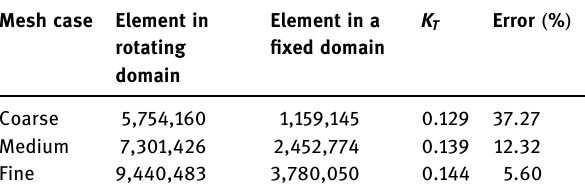
Table 7: Mesh dependency study of Case 1 using the Zwart model J